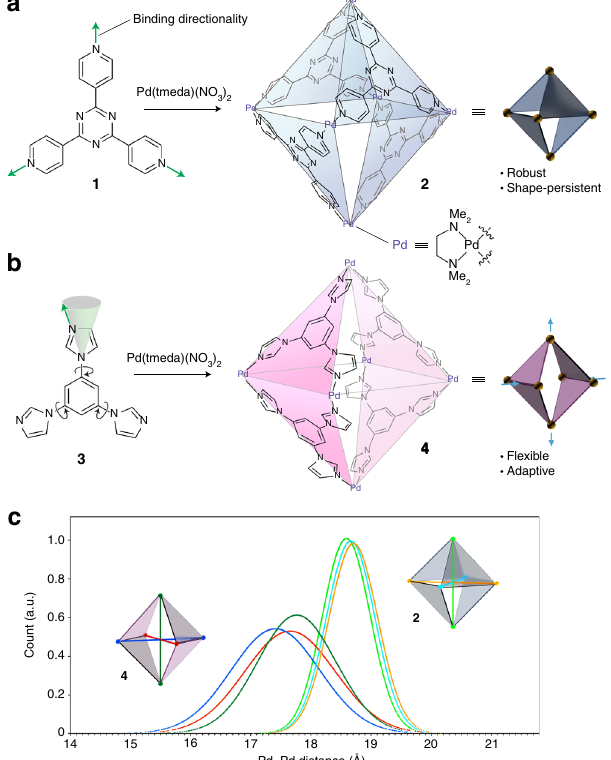
Fig. 1 Tripyridine- and triimidazole-based cages and their mechanical properties. a Synthesis of an octahedral cage 2 from tripyridine ligand 1 and a cis - blocked Pd acceptor 33 . b Synthesis of octahedral cage 4 from the same Pd precursor and triimidazole ligand 34 3 . c Quantifying the fl exibility of cages 2 and 4 : calculated distributions of Pd – Pd distances in 2 and 4 at room